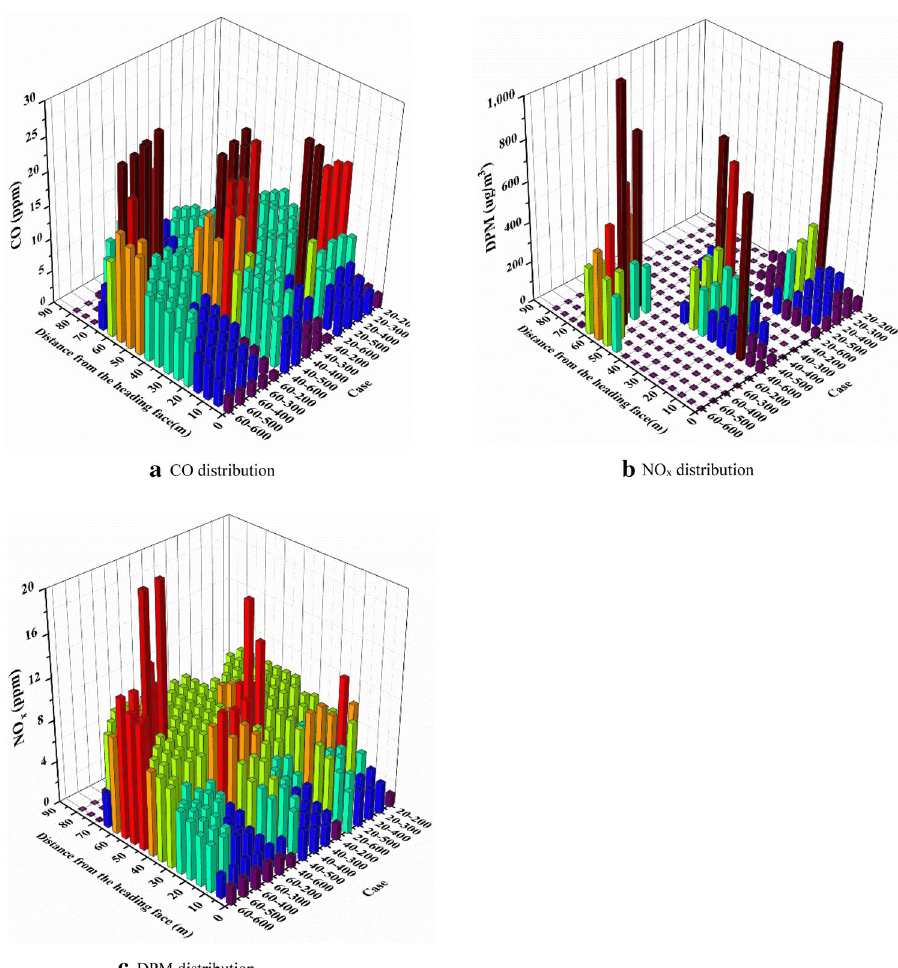
Figure 13. Variation of pollutant concentration along the path.